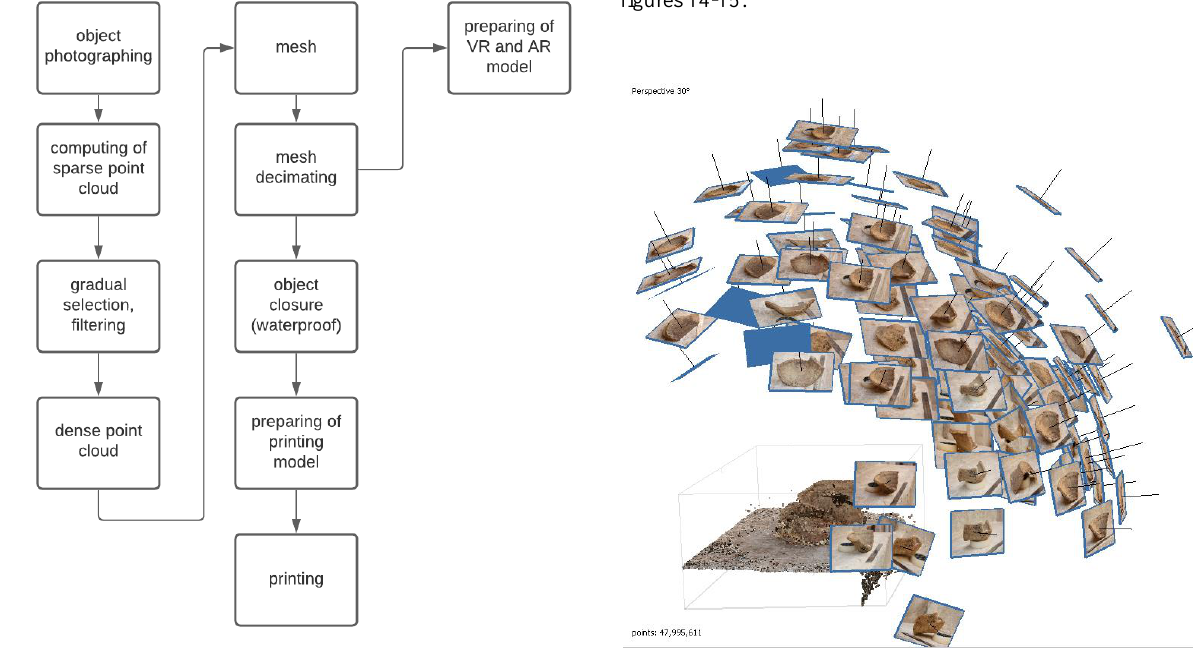
Figure 7. Data processing flowchart